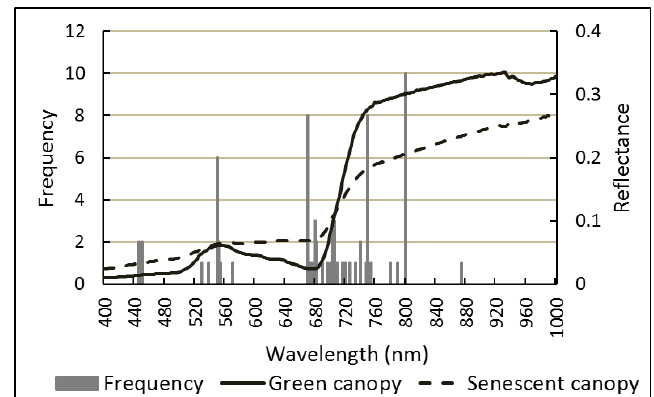
Figure 6. Frequency of wavelengths used in all the vegetation indices (listed in Table 1). The grey bars represent frequency of different wavelengths. The solid curve is a typical reflectance of green canopies and the dashed curve is of a senescent canopy (i.e., mixed green and senescent vegetation).